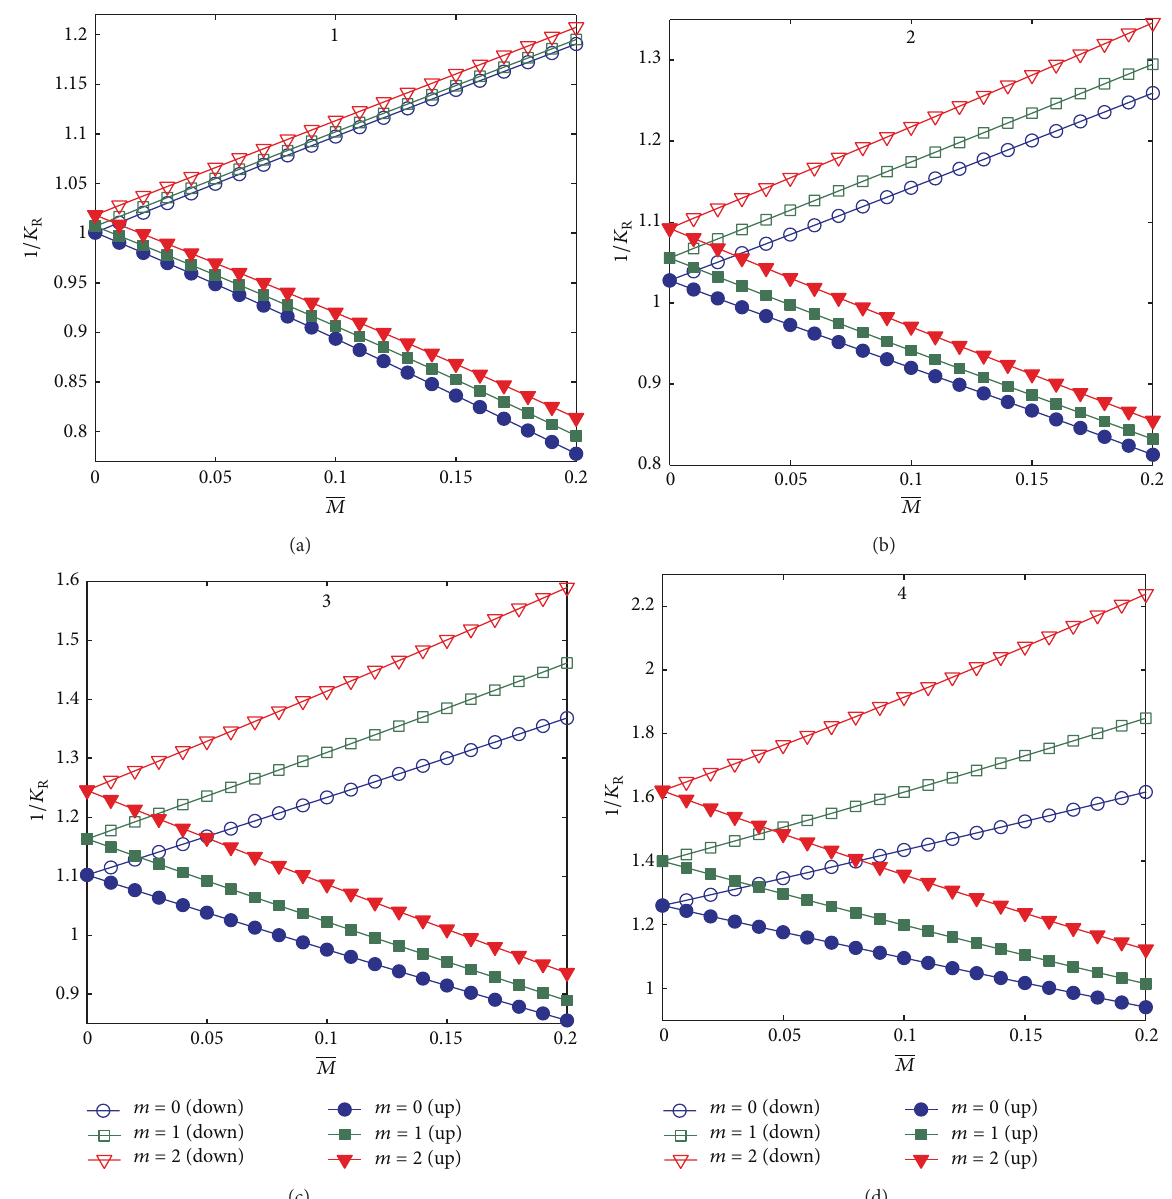
Figure 5: (Color online) Comparison of the relative phase velocity of the first four axial acoustic modes among the three circumferential modes in the turbulent flow confined by the lined-walled